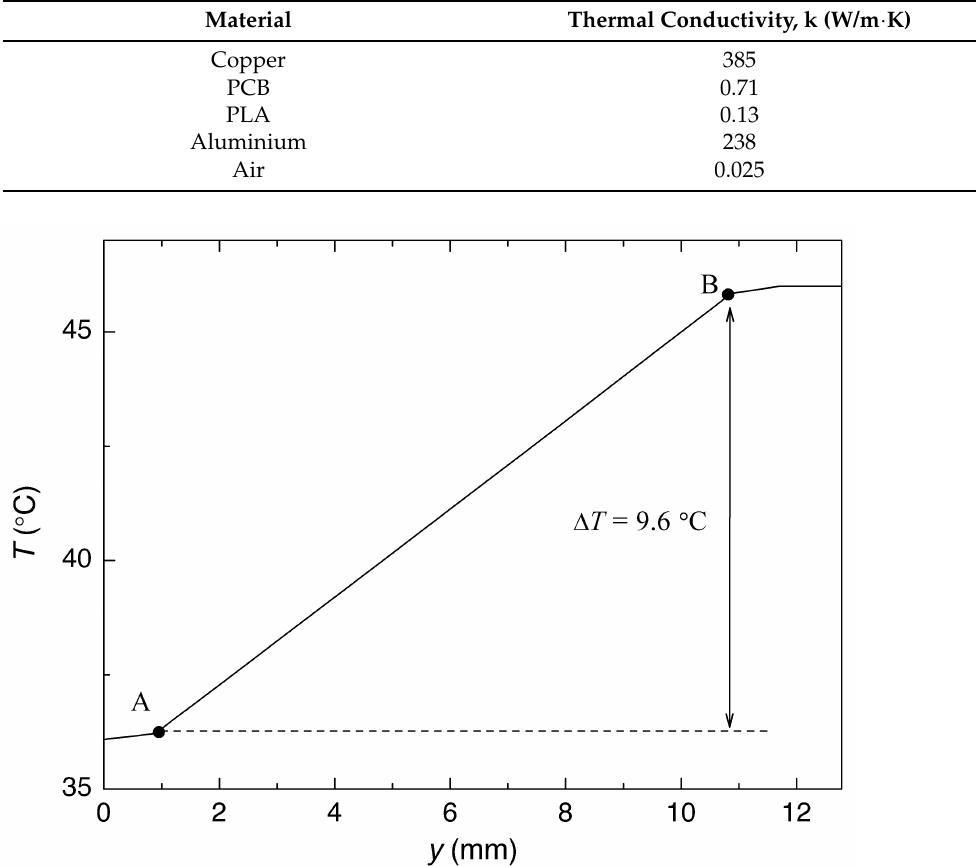
Figure 8. Temperature variation in depth (along the axis of the